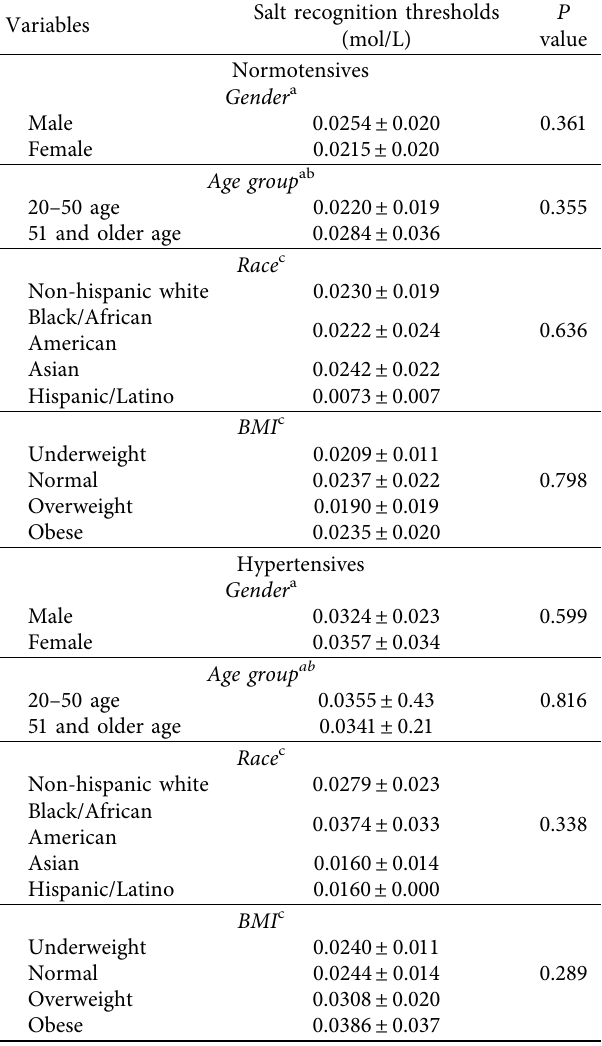
Table 5: Genotypes and allele distribution in normotensive and hypertensive